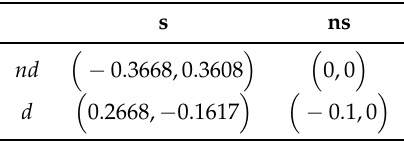
Table 3. Payoffs values for the game when n 1 = 4 and n 2 = 1. The first entry of the payoff vector is the server payoff, the second is the client payoff.